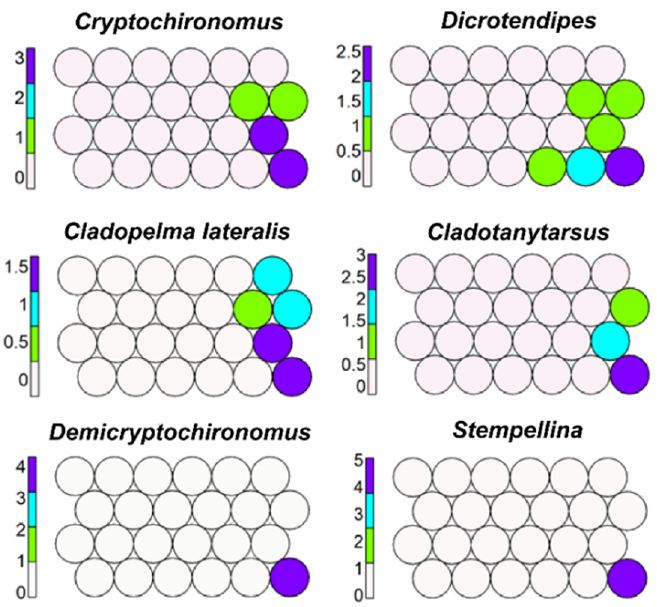
Figure 7. Unsupervised map of six morphotaxa characterizing lake sublittorals. Chironomus anthracinus , C. plumosus , Microchironomus , Stictochironomus , Prodiamesa olivacea, and Micropsectra radialis prevail in cells 11, 12, and 18 (Figure 8) and usually characterize large lakes (LL), but the last two occur also in cold springs.